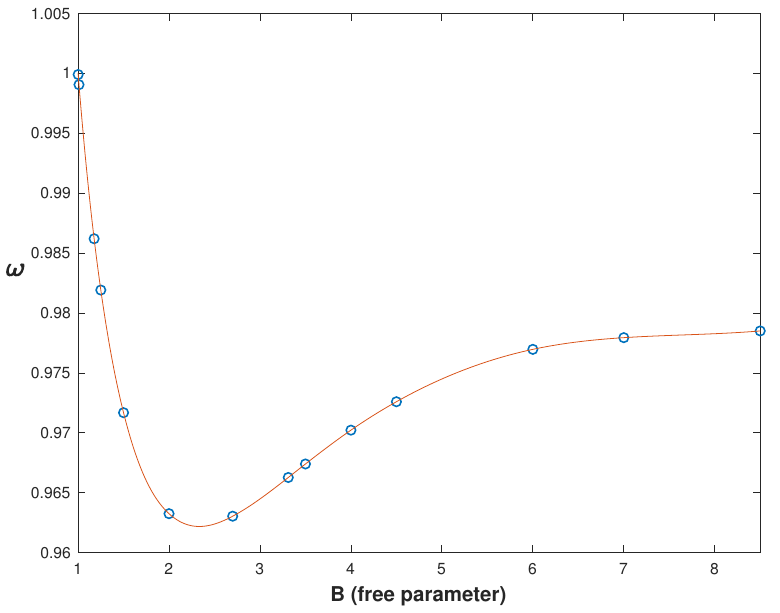
Figure 7. Frequency ω against the free parameter B